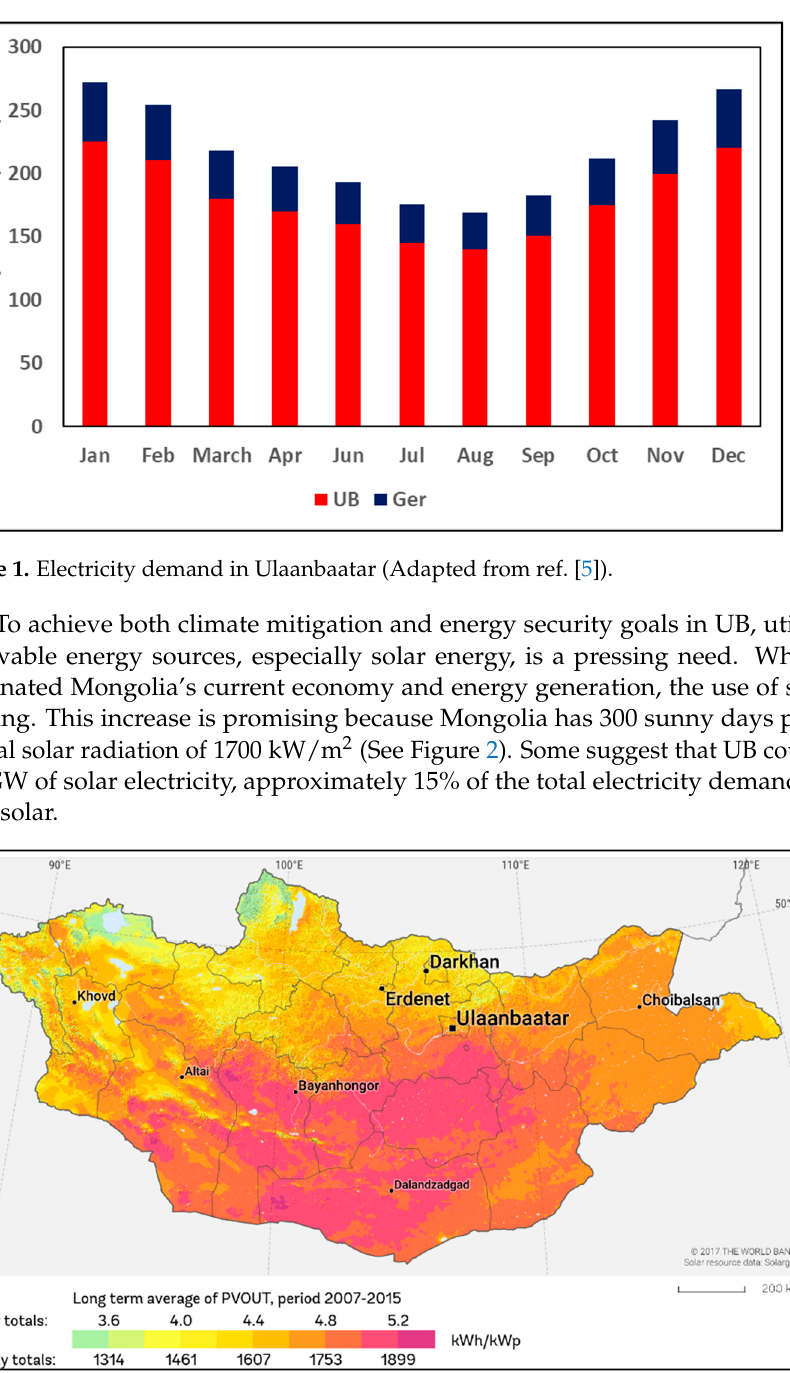
Figure 2. Mongolia potential for solar energy [6].